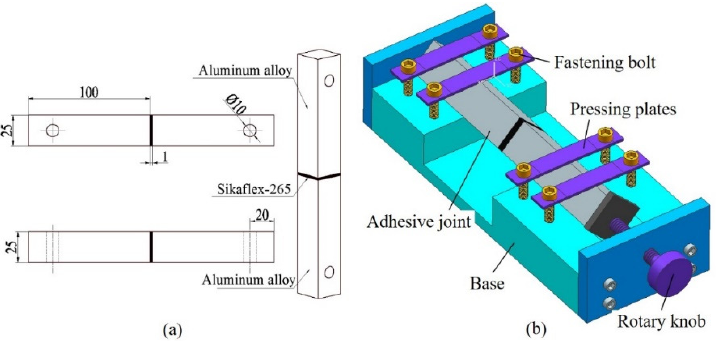
Figure 2. ( a ) Geometric dimension of BJ (unit: mm), ( b ) schematic diagram of bonding fixture. The joints were prepared in a dust-free and stable environment (temperature 25 ± 5 ◦ C, humidity 50 ± 5%). To avoid the failure of bonding due to improper surface treatment, the surface of the bonding substrate was treated first, and the aluminum alloy was cross- polished with 80 mesh sandpaper along the diagonal direction of the bonding surface to increase the surface roughness. Sika Remover 208, Sika Aktivator, and Sika Prime-206G + P were used successively to wipe the bonded surface [20]. When all the above pretreatment processes were completed, glue was applied on the surface of the aluminum alloy substrate, and the adhesive fixture was used for bonding, as shown in Figure 2b. The distance